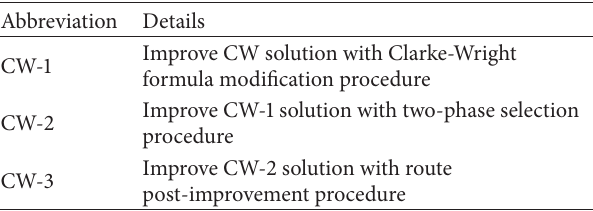
Table 2: The different features of the proposed